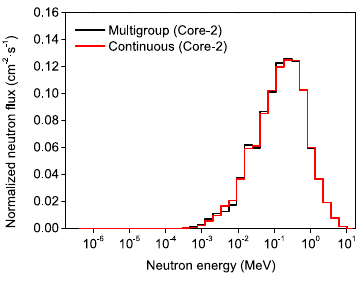
Figure 7. Neutron flux vs energy of core